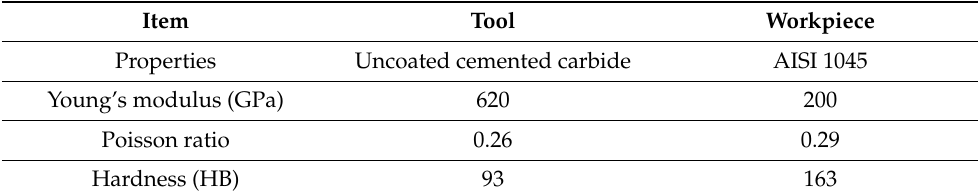
Table 2. Mechanical properties of workpiece and tool materials